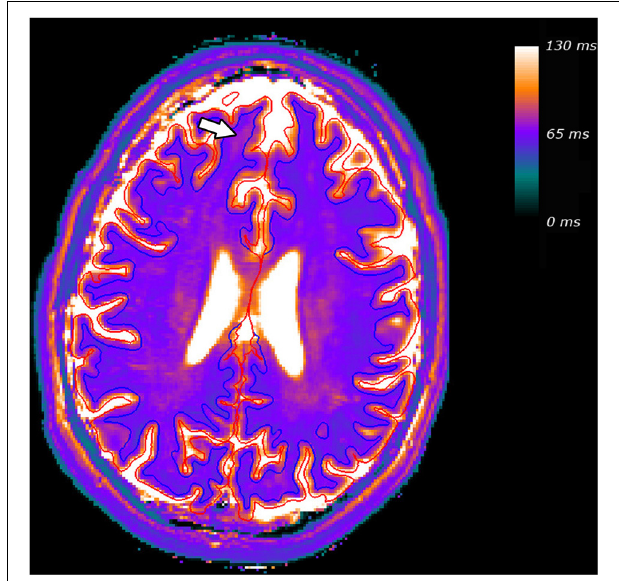
FIGURE 2 | Tissue segmentation for a representative patient, superimposed on the T2 map. The blue line indicates the junction between cortex and WM and the red line the cortical surface. The FCD and the resulting increased subcortical T2-values are marked with an arrow.